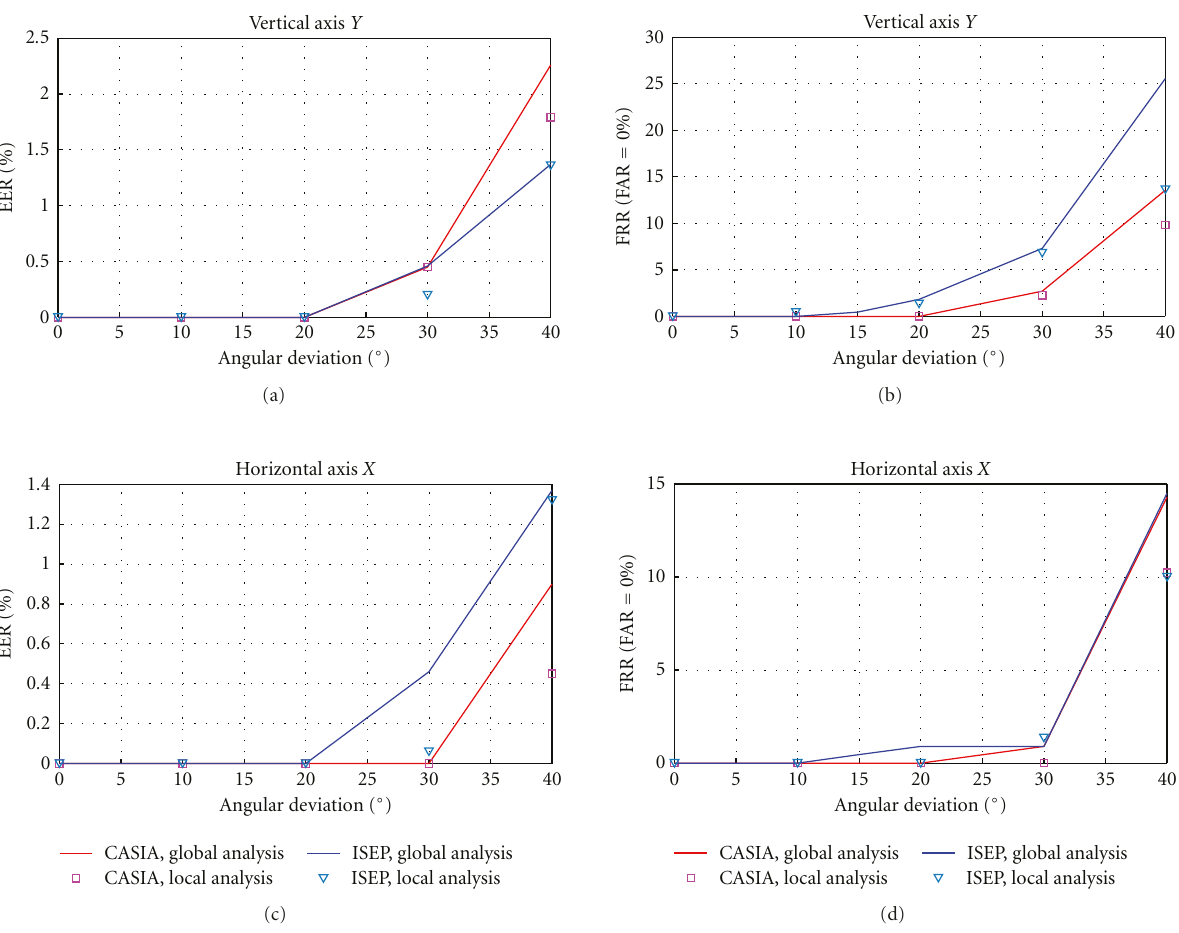
Figure 20: (a, c) EER and (b, d) FAR (FRR = 0%) as a function of the optical axis deviation in the vertical (a, b) and horizontal (c, d) directions, measured on CASIA and ISEP